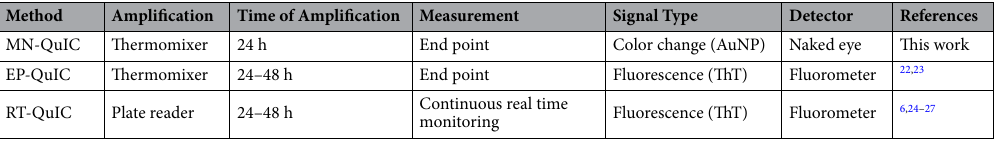
Table 1. Comparison among quaking amplification